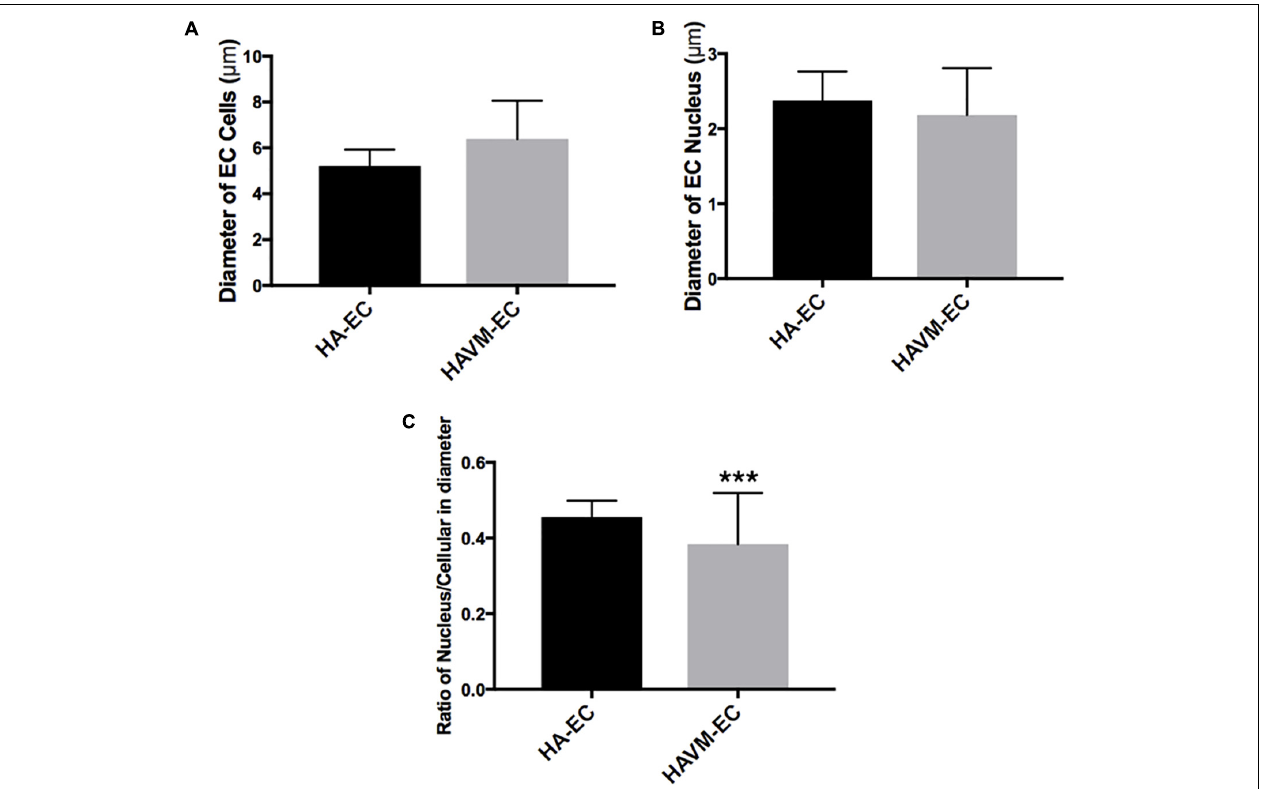
FIGURE 3 | Changes of morphology in cAVM-ECs. (A) Average diameters of body in cAVM-ECs and HA-ECs, (6.391 ± 0.5283) µ m in cAVM-ECs, were larger than that (5.222 ± 0.2224) µ m in HA-ECs ( p > 0.05); (B) The average diameters of nucleus in cAVM-ECs (2.183 ± 0.1981) µ m, were smaller than that (2.377 ± 0.1226) µ m in HA-ECs ( p > 0.05); (C) Ratios of nucleus to cellular in cAVM-ECs was (0.3437 ± 0.02426), and that in HA-ECs was (0.4557 ± 0.01356), and there was a significant difference between them ( p < 0.05).